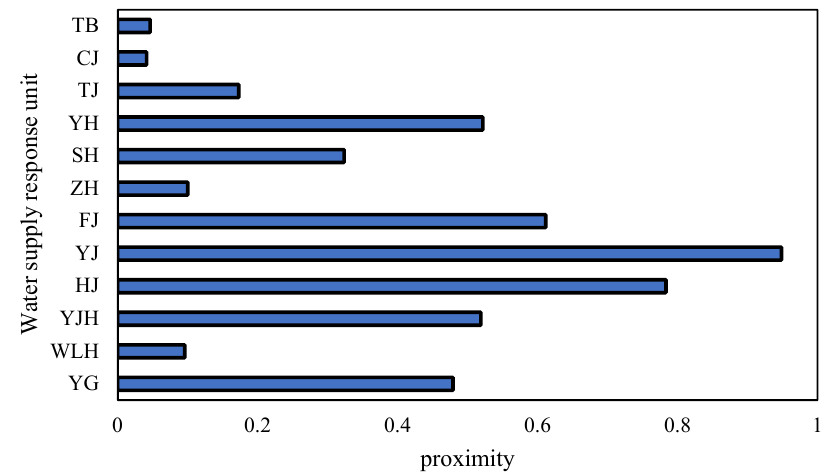
Figure 9. Calculation results of proximity.